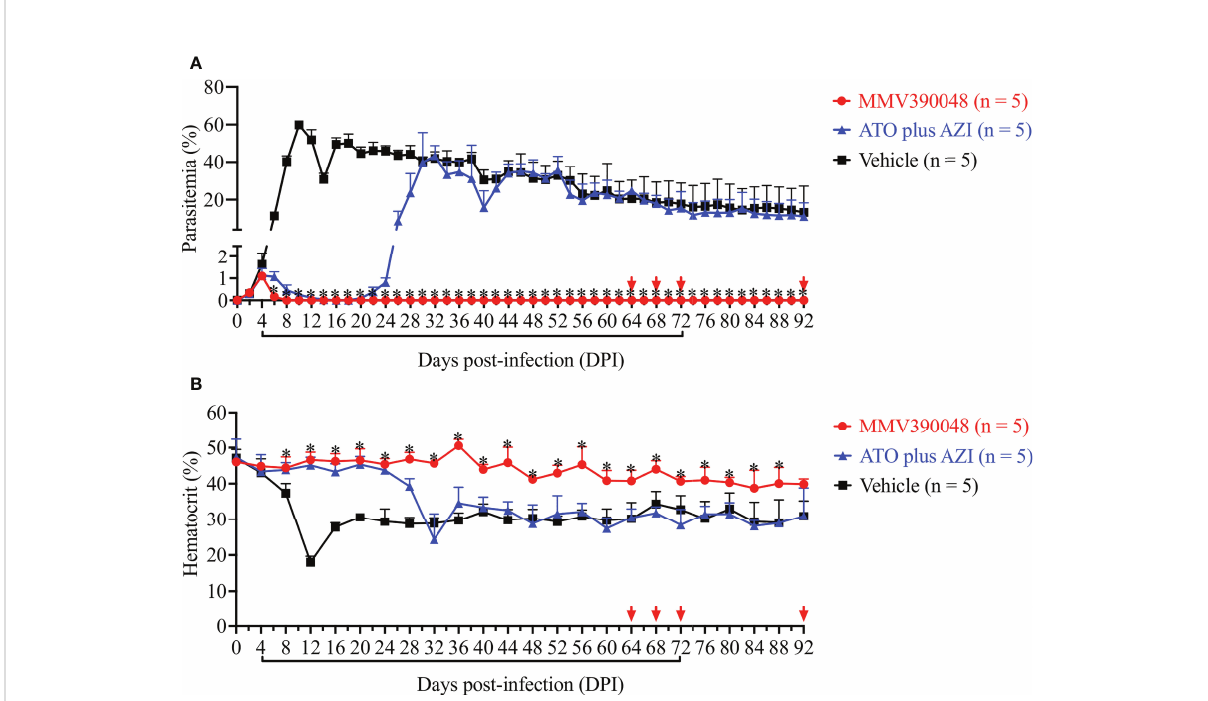
FIGURE 1 The ef fi cacy of consecutive treatment with MMV390048 in Babesia microti -infected severe combined immunode fi ciency (SCID) mice. (A) Course of parasitemia in vehicle-, or atovaquone (ATO) plus azithromycin- (AZI), or MMV390048-treated groups. (B) Hematocrit changes in B. microti -infected SCID mice treated with vehicle, or ATO plus AZI, or MMV390048. Treatment was given orally starting from 4 days post- infection (DPI). The black lines indicate time of treatment and the red arrows indicate testing negative in PCR assay. The asterisks indicate a signi fi cant difference ( P < 0.05) between the drug-treated groups and vehicle-treated group. Parasitemia was calculated by counting infected RBCs among 3,000 RBCs using Giemsa-stained blood